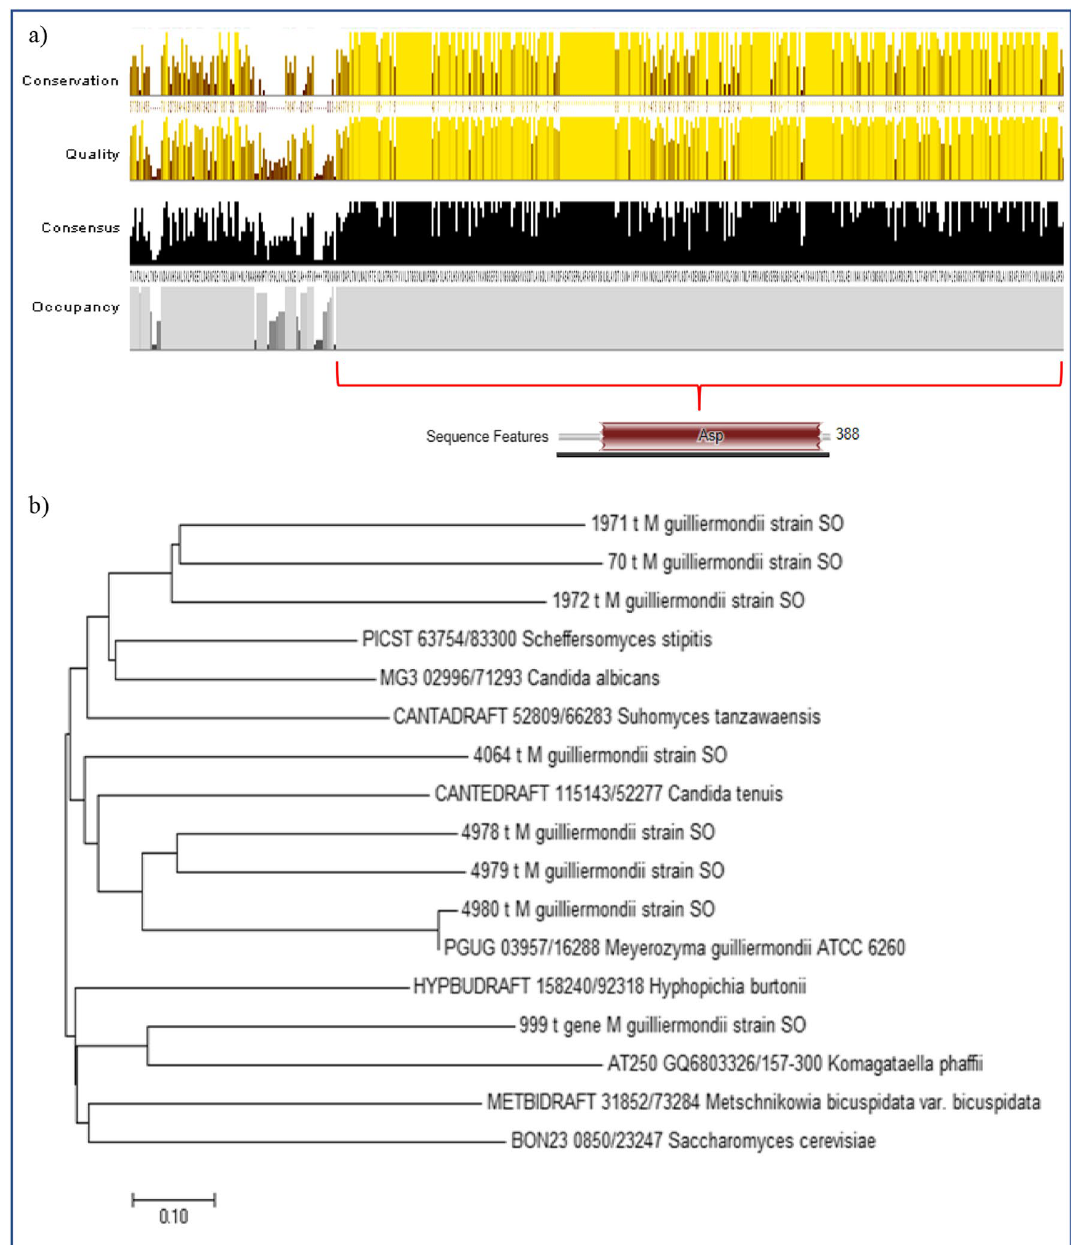
Fig. 2 Profiling of putative aspartic proteases encoding gene according to public databases to signify virulence factors as indicated pathogenic in C. albicans . a The consensus region of aspartic proteases from HMM hits coordinate represented using BioEdit and b the phylogenetic tree of M. guilliermondii strain SO from HMM protease model. Three genes of M. guilliermondii strain SO (1971_t, 1972_t and 70_t) shared connected elements with C.